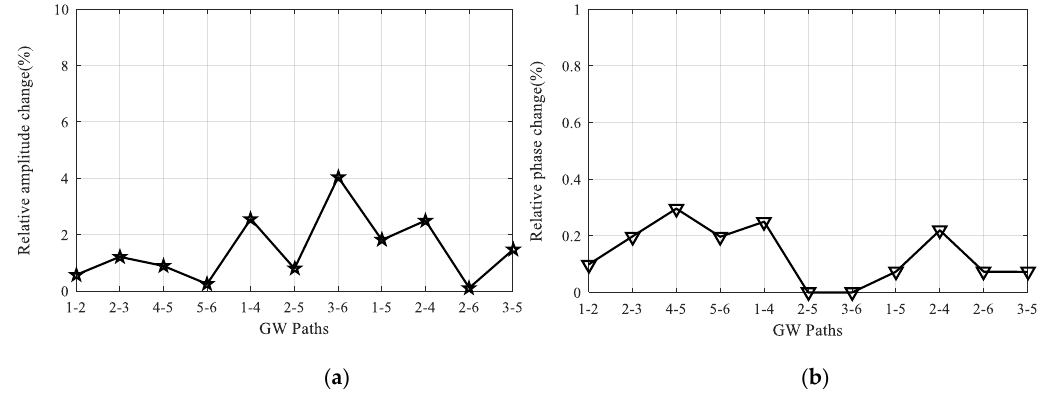
Figure 9. Relative signal change of all the paths after temperature tests. ( a ) Relative amplitude change. ( b ) Relative phase change.